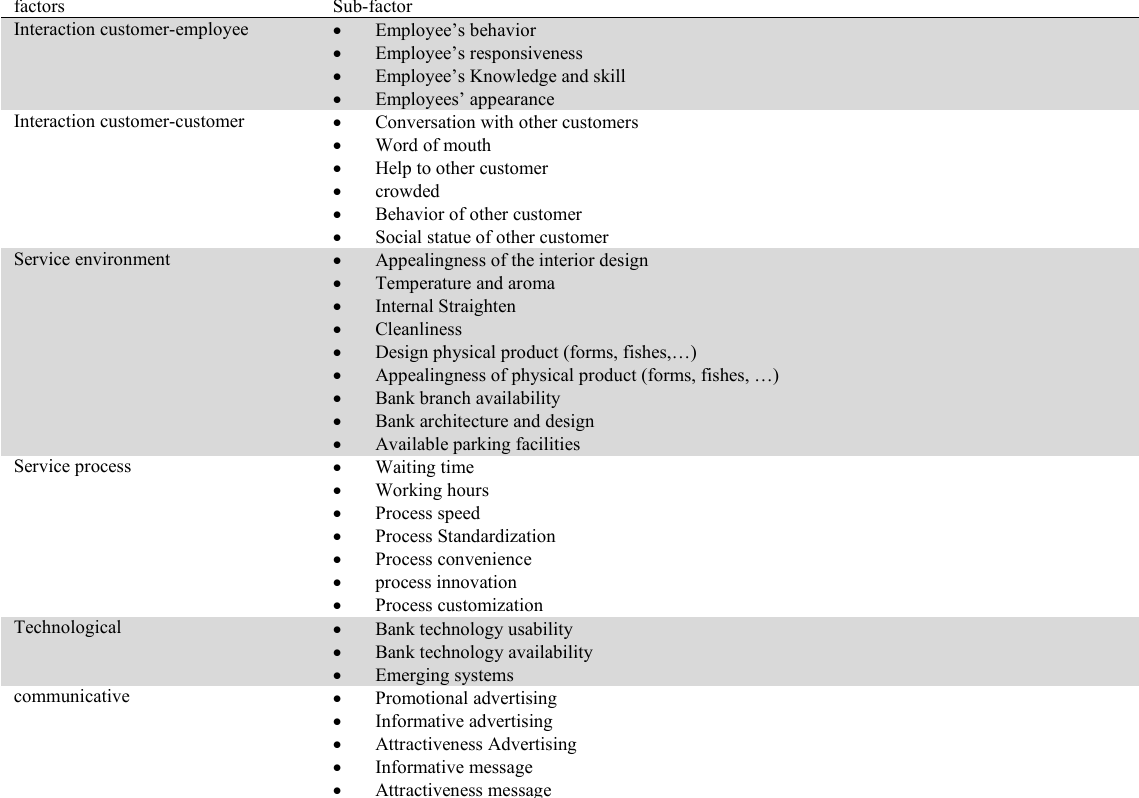
Factors of service experience